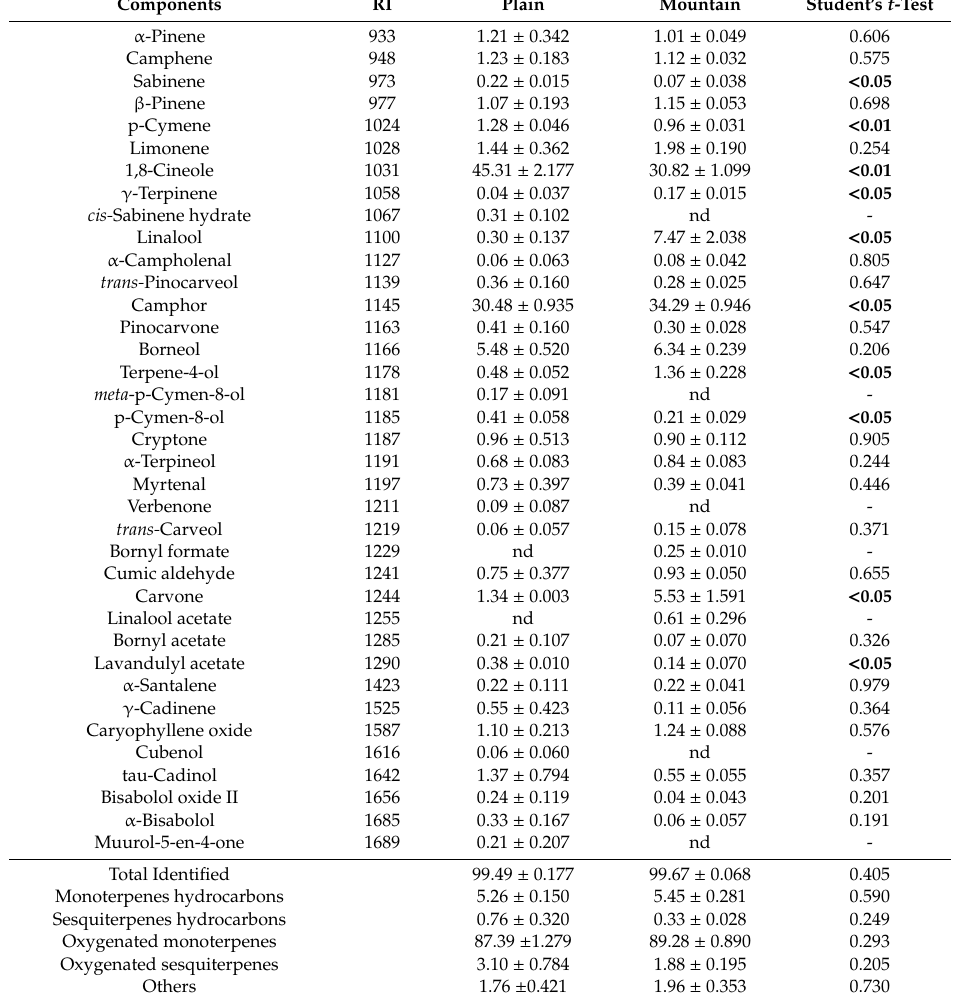
Table 5. Chemical composition (%) of essential oils of lavender plants grown at di ff erent altitudes (plain vs. mountain). Data are expressed as means ± SE (n = 3), and significant di ff erences ( p < 0.05, p < 0.01, p < 0.001) in bold between treatments are indicated by Student’s t -test p -values.